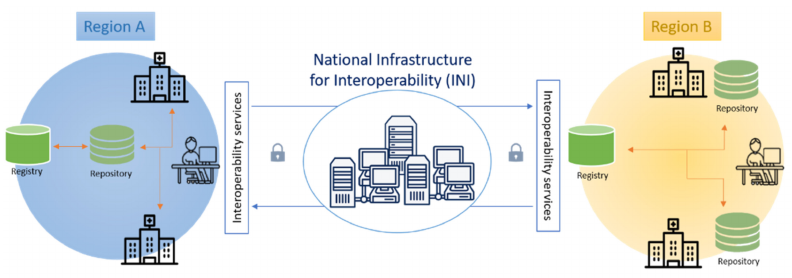
Figure 1. FSE architectural framework and interoperability